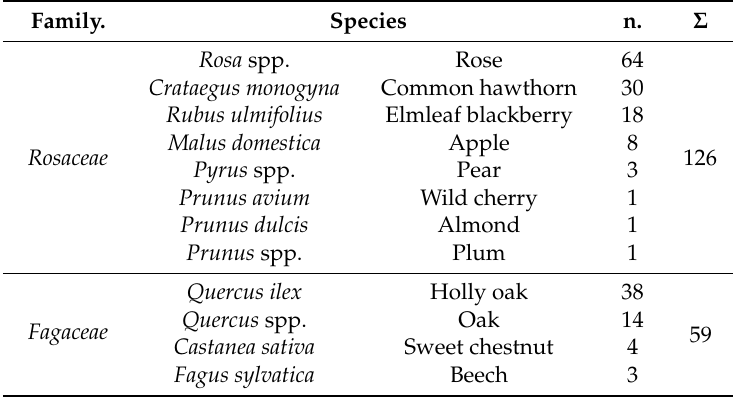
Table 2. Marian verdant advocations in Spain (n ≥ 20).